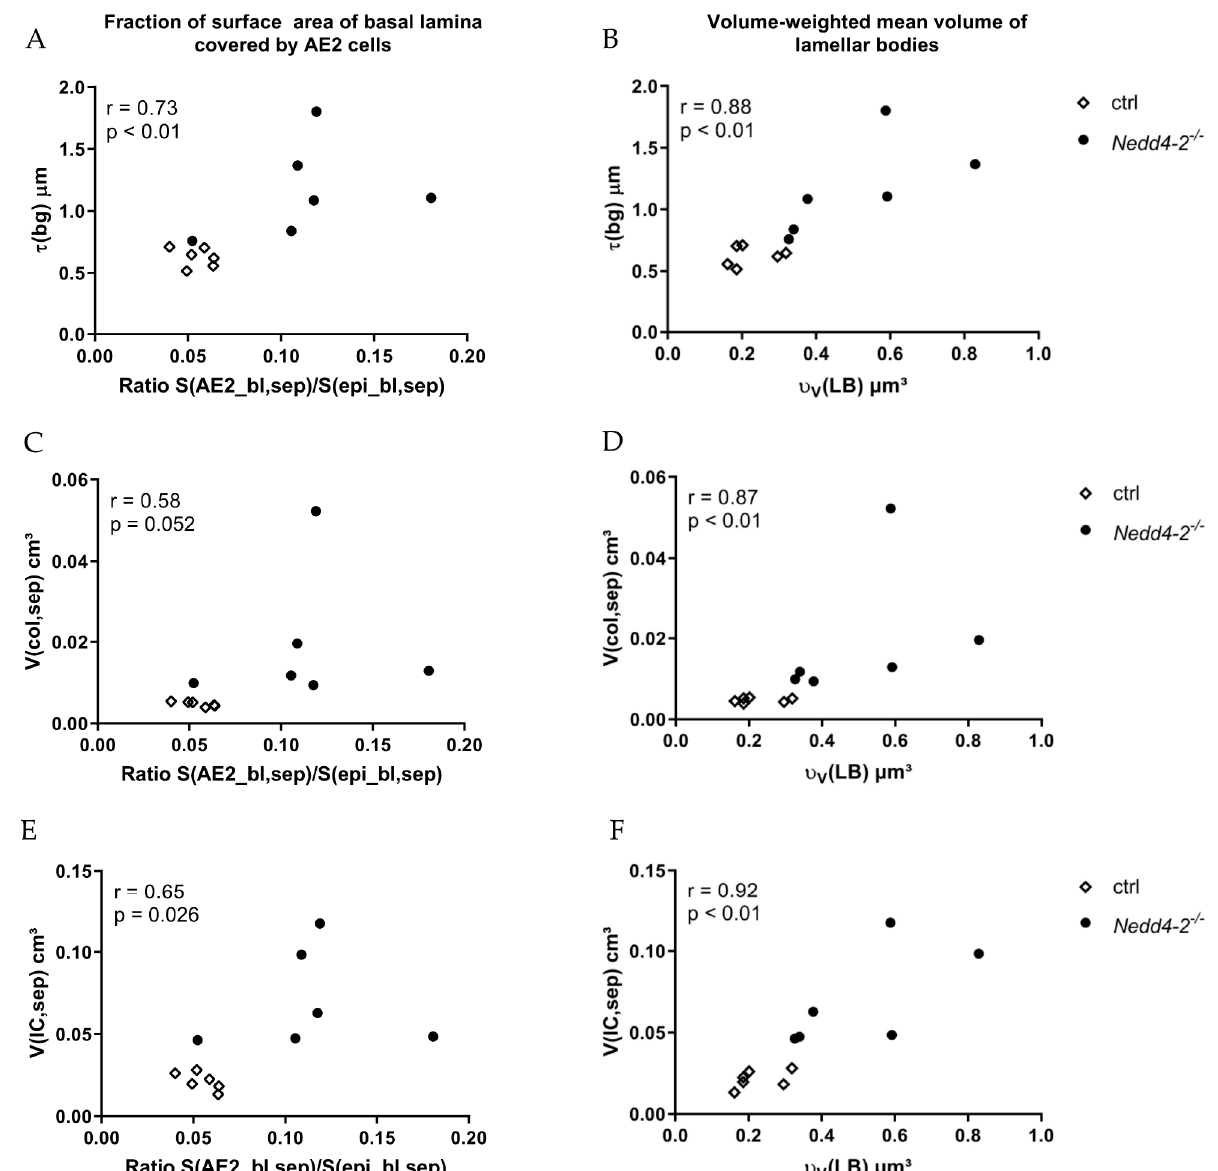
Figure 5. Correlation between different structural data of Nedd4-2 -deficient ( Nedd4-2 − / − ) lungs after 12 weeks. ( A ) The arithmetic mean thickness of the blood–gas barrier demonstrates a highly significant positive correlation with the fraction of surface area of basal lamina covered by AE2 cells and ( B ) a highly significant positive correlation with the volume-weighted mean volume of lamellar bodies. ( C ) The volume of collagen fibrils demonstrates no significant correlation with the fraction of surface area of basal lamina covered by AE2 cells and ( D ) a positive, highly significant correlation with the volume-weighted mean volume of lamellar bodies. ( E ) The volume of interstitial cells demonstrates a positive significant correlation with the fraction of surface area of basal lamina covered by AE2 cells and ( F ) a positive, highly significant correlation with the volume-weighted mean volume of lamellar bodies. The Spearman correlation coefficient r and statistical significance p are provided.